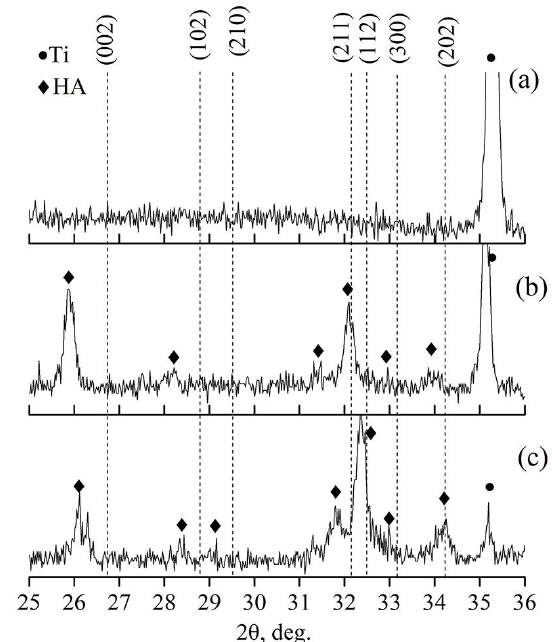
Figure 2. X-ray profiles of Cu-HA coating on Ti as-deposited ( a ), Cu-HA coating on Ti after annealing at 450 °C for 3 h ( b ) and Cu-HA coating on Ti after annealing at 700 °C for 3 h ( c ). Table 1. Calculated values for hydroxyapatite structural parameters ( a and c —lattice parameters).